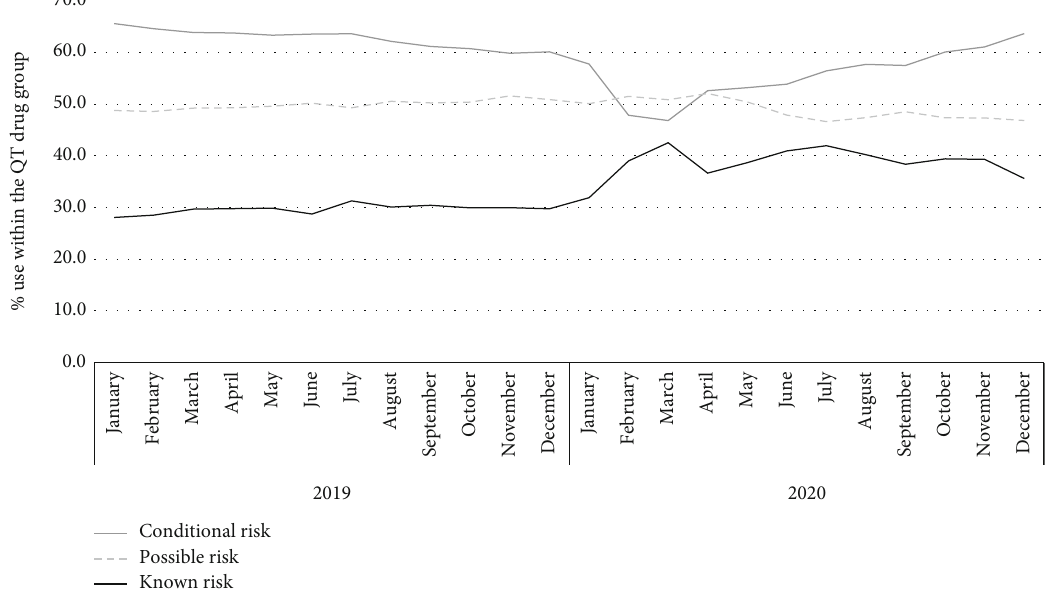
Figure 1: Proportion of patients with QT-prolonging drugs according to risk category, Colombia, 2019 –